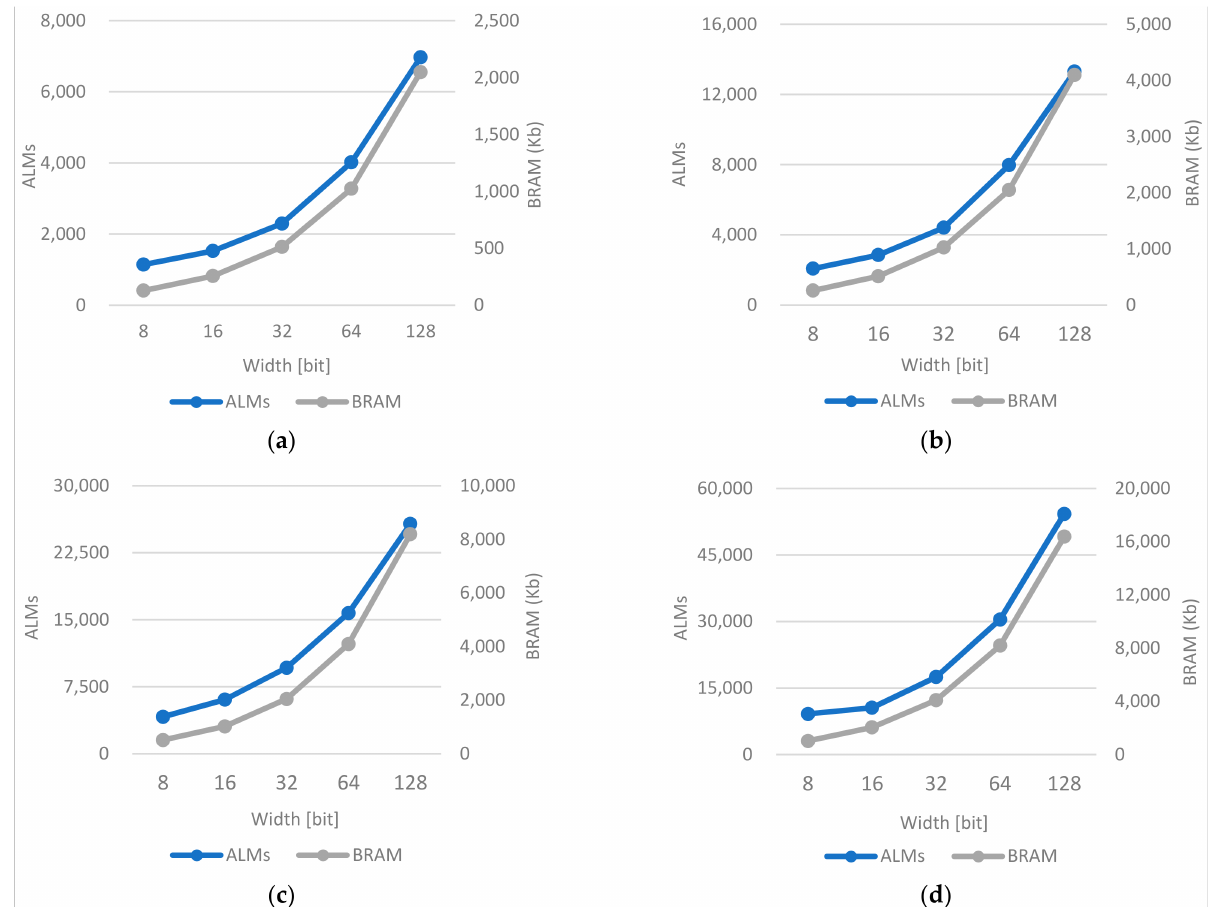
Figure 17. Resource consumption of RAM-based TCAM with different sizes. ( a ) Resource consumption with 512 depth; ( b ) resource consumption with 1024 depth; ( c ) resource consumption with 2048 depth; ( d ) resource consumption with 4096